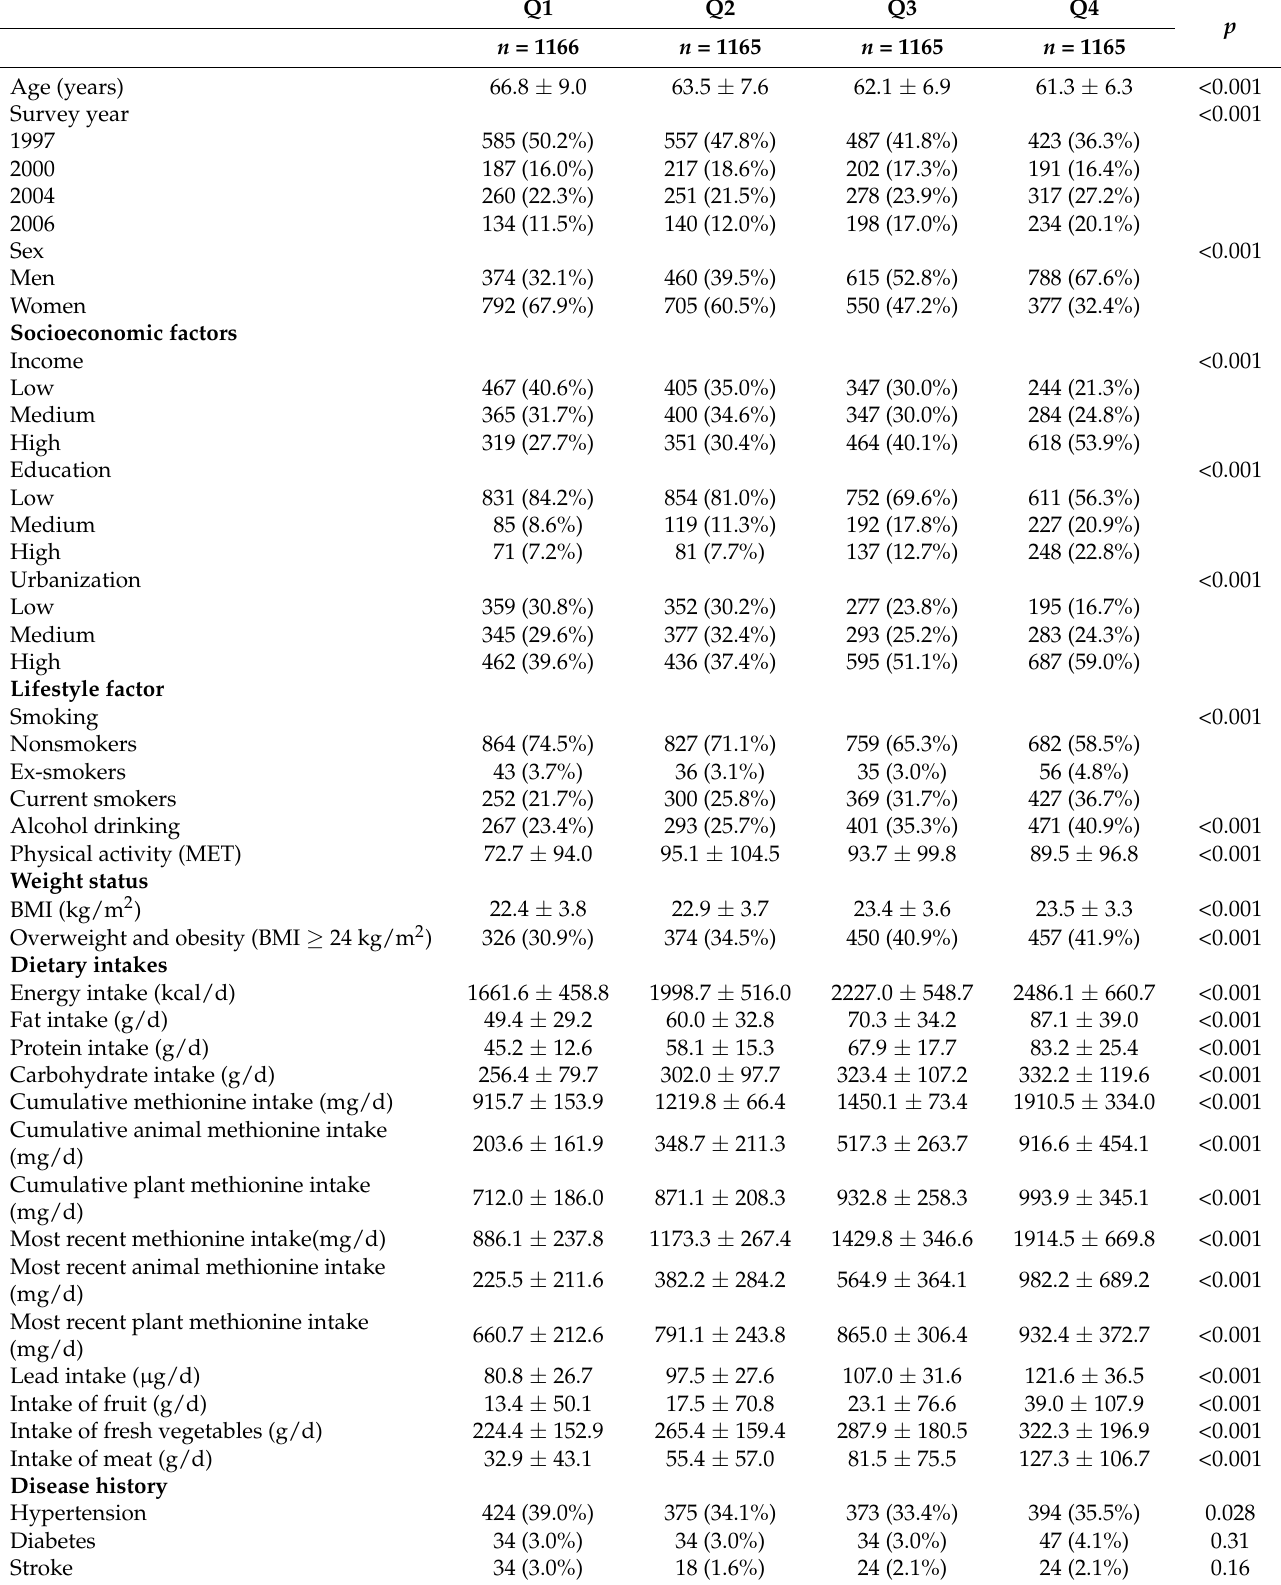
Table 1. Sample characteristics of Chinese adults aged ≥ 55 years attending the first cognitive